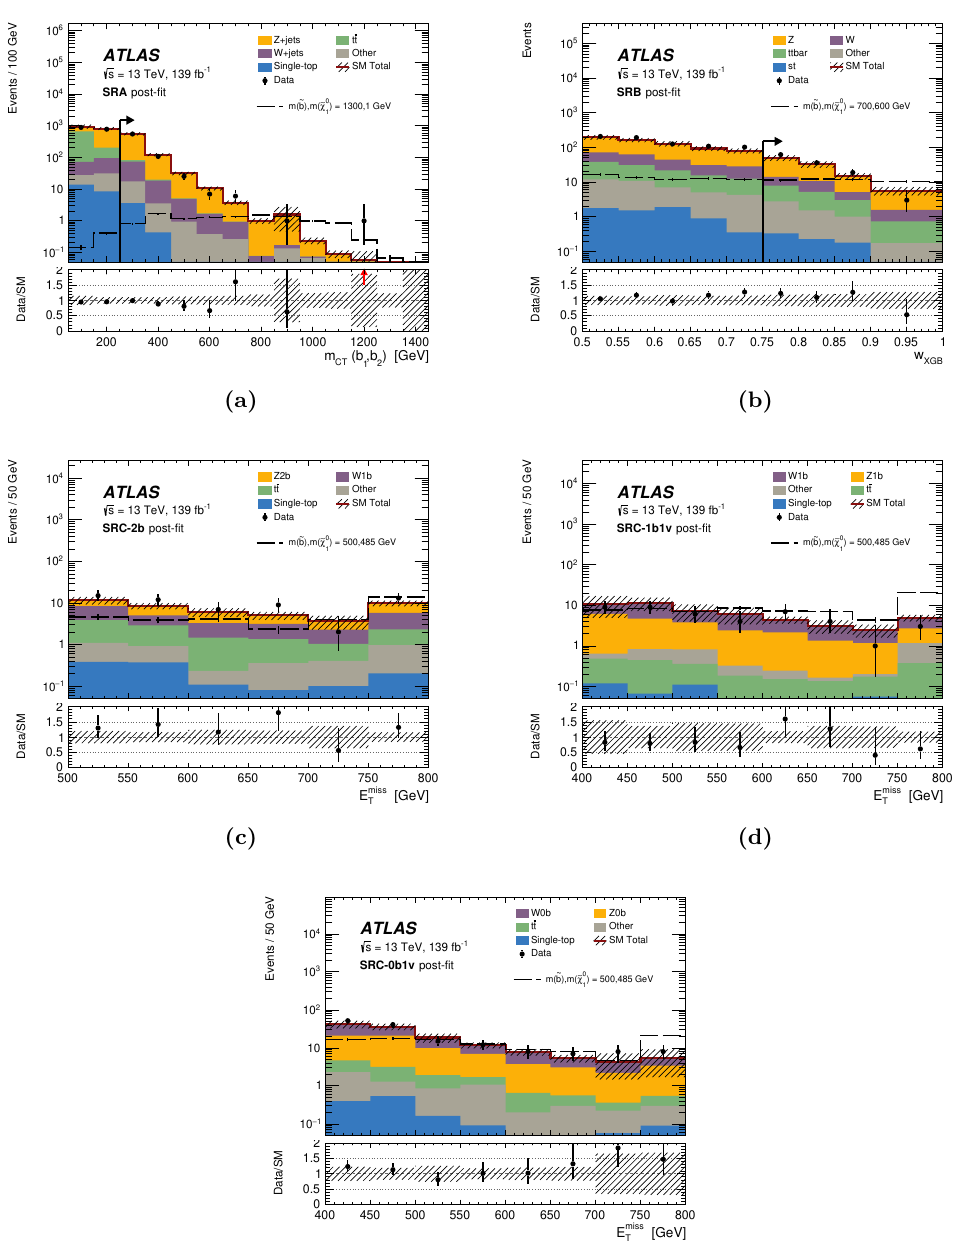
in (c) SRC-2b, (d) T